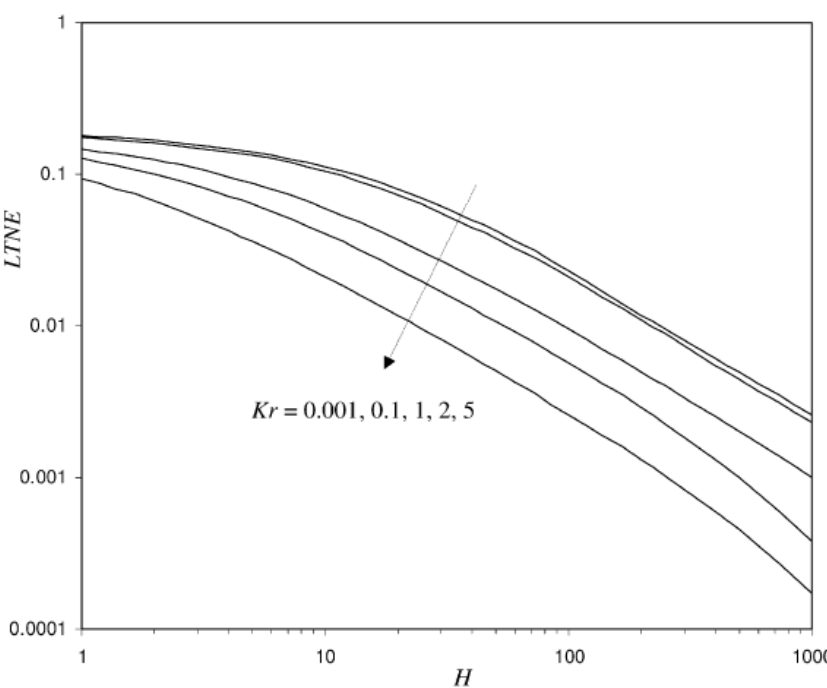
Figure 44. Wong and Saeid [50] reported this results for the LTNE parameter against the inter- phase convective heat transfer parameter ( H ) and for different porosity scaled thermal conductivity ratio ( K r ). To sum up, for a major clarification, Table 1 summaries the range of characteristic porous media parameters within which the LTE hypothesis is verified. Table 1. The range of characteristic porous media parameters within which the LTE hypothesis is